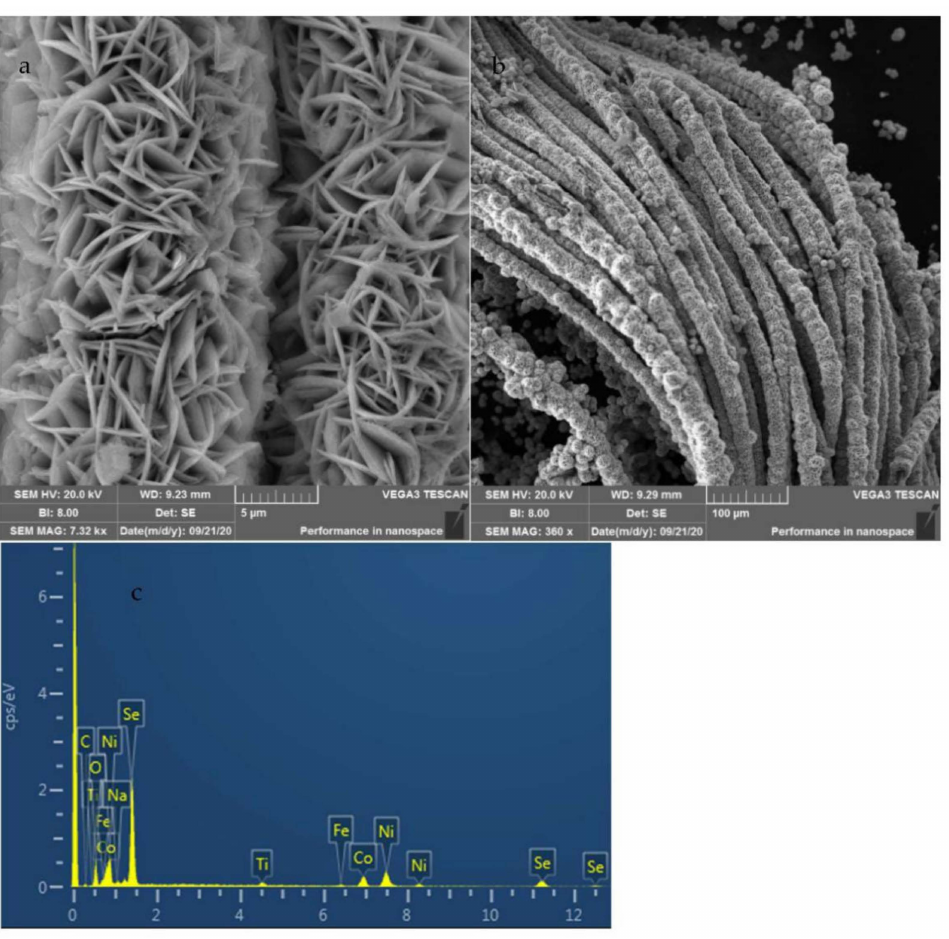
Figure 2. SEM image ( a , b ) and EDX spectrum ( c ) of (Ni 0.62 Co 0.35 Fe 0.03 ) 3 Se 4